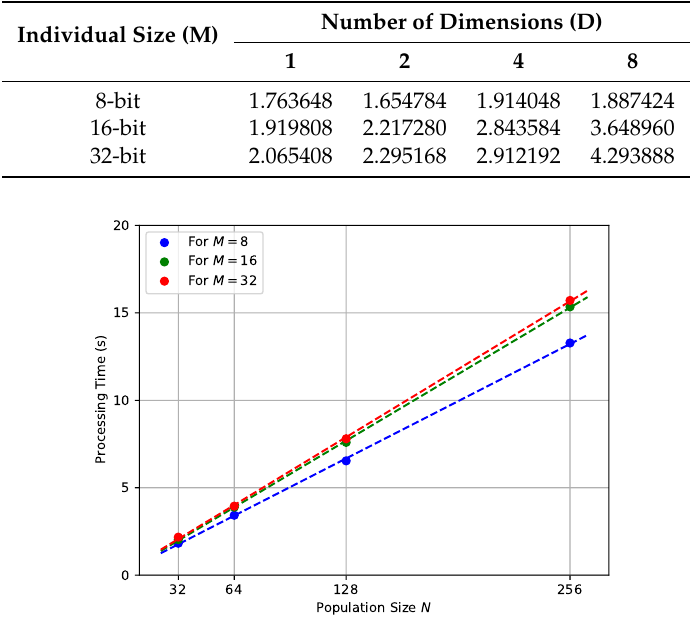
Table 9. Average processing time (in seconds) for different values of D, using f 2 ( ¯x ) with N = 32 and K = 8.